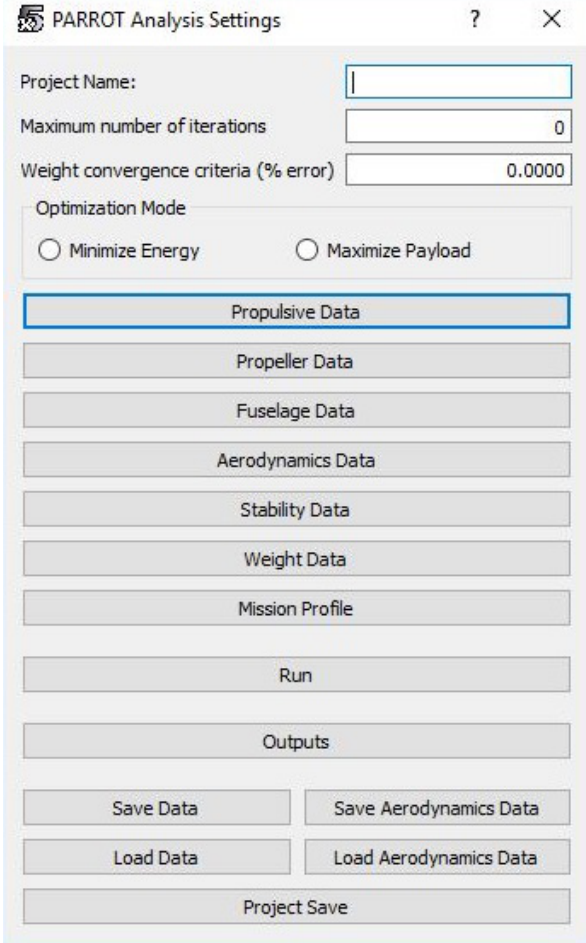
Figure 2: PARROT